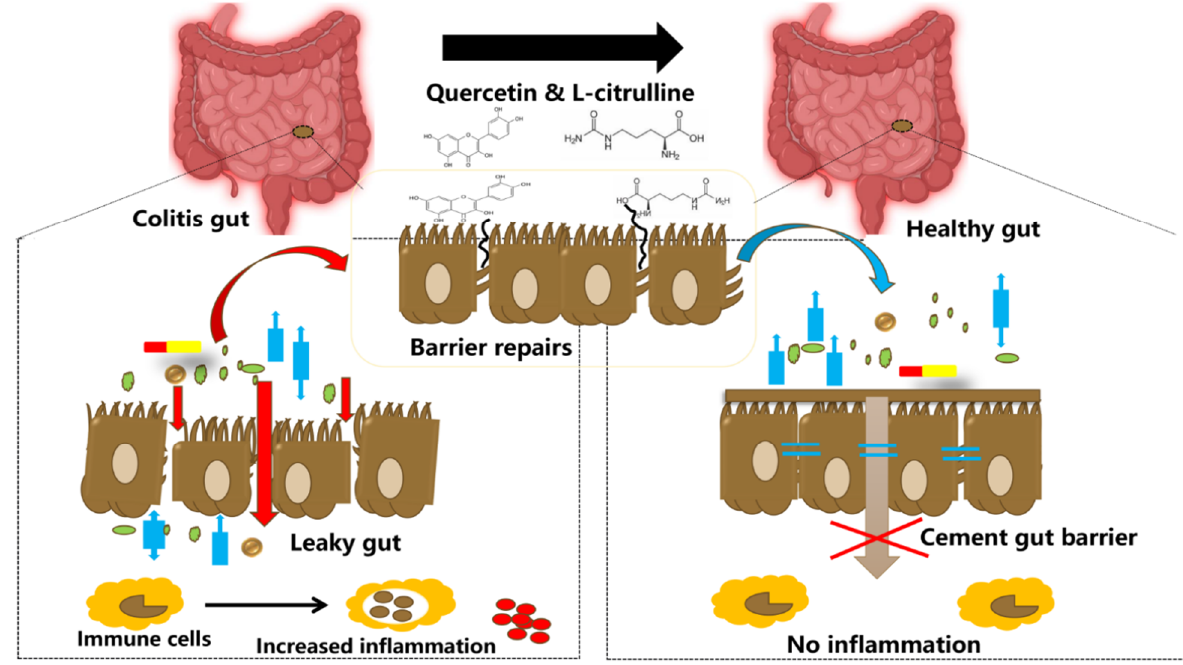
Figure 6. Illustration showing tightening of the gut barrier cells and reduced inflammation due to the introduction of quercetin and L -citrulline.